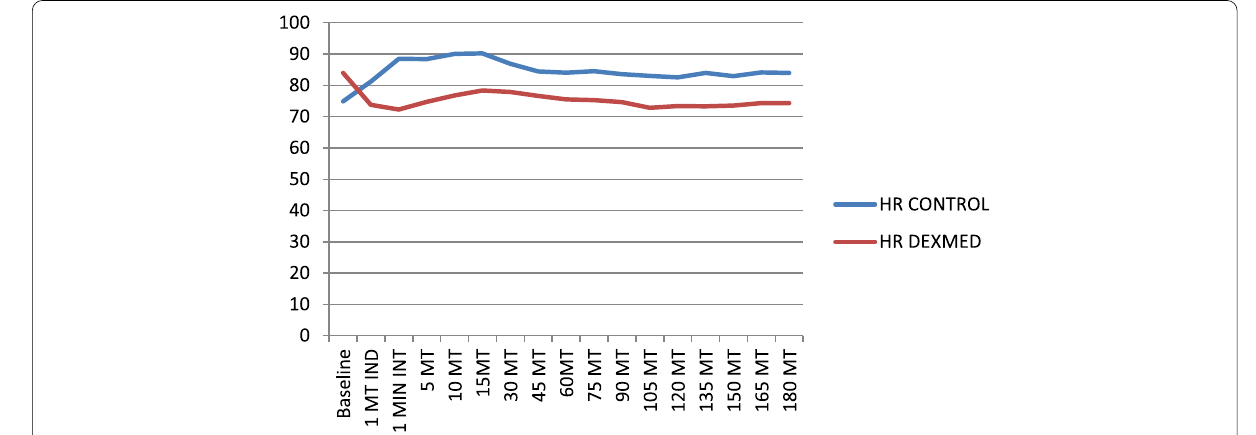
Fig. 4 Heart rate response with the control and dexmeditomidine